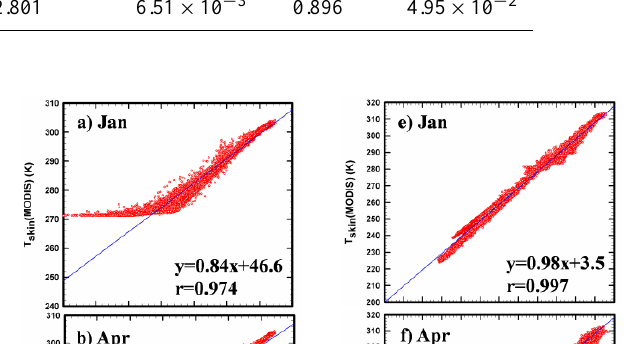
Fig. 4. Same as in Fig. 3, except for the oceans at (a) 60–90 ◦ N and (b) 60–90 ◦ S. Figure 4. Same as in Fig. 3, except for the oceans at a) 60-90 N and b) 60-90 S. 3